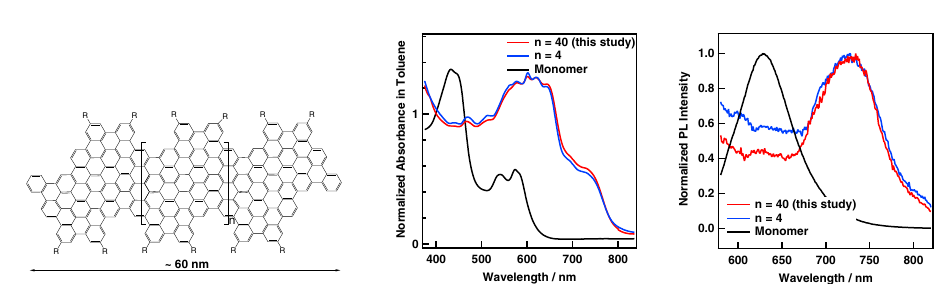
Figure 1. Molecular structure of the GNR and its absorption and PL spectra in toluene. The spectra are independent of the length while redshifted from the monomer. The absorption spectrum shows a convoluted structure of peaks, while the lowest main exciton peak (735 nm) is identified in the PL.